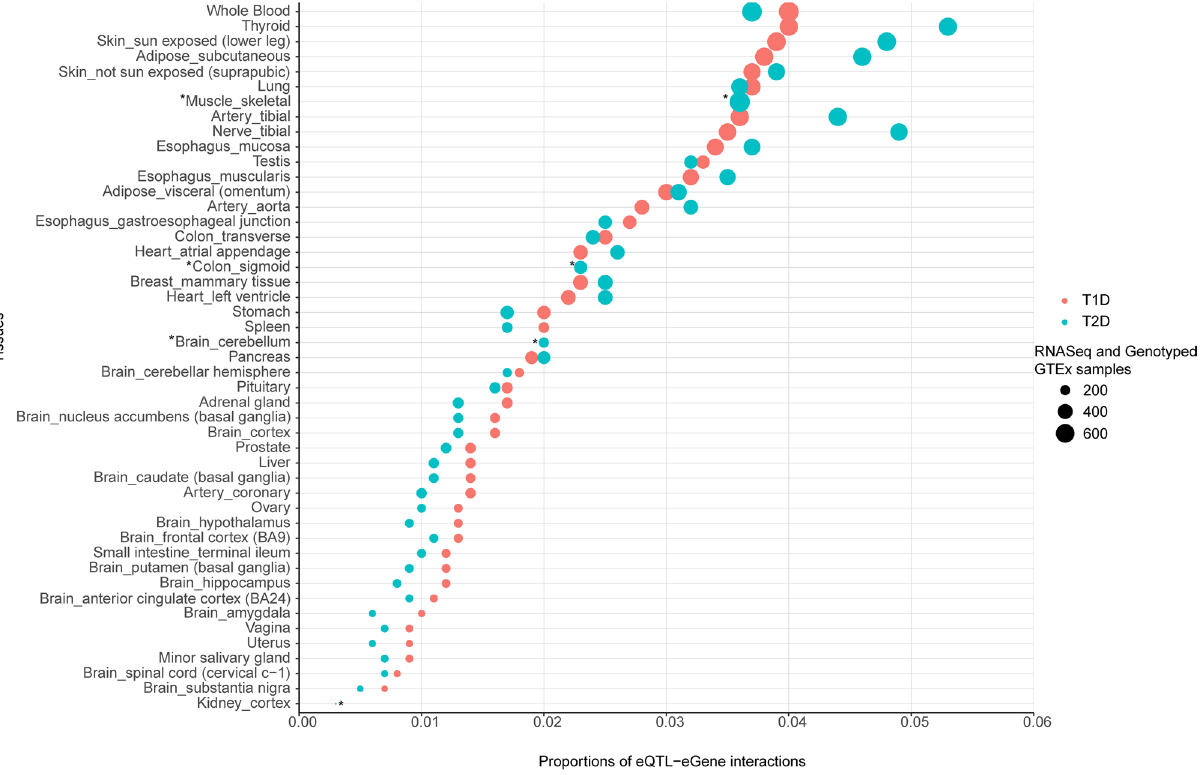
Figure 4. Functional eQTL effects are variably distributed across tissues. The proportions of significant T1D and T2D eQTL-eGene interactions across tissues (x-axis) in comparison to number of GTEx tissue samples (circles). The top ranked tissues with the highest number of functional T1D eQTL-eGene interactions include whole blood, thyroid, skin and adipose tissues. T2D eQTLs were greatest in the thyroid, tibial nerve, skin and adipose subcutaneous tissues. *Tissues with the same number of functional T1D and T2D eQTL-eGenes